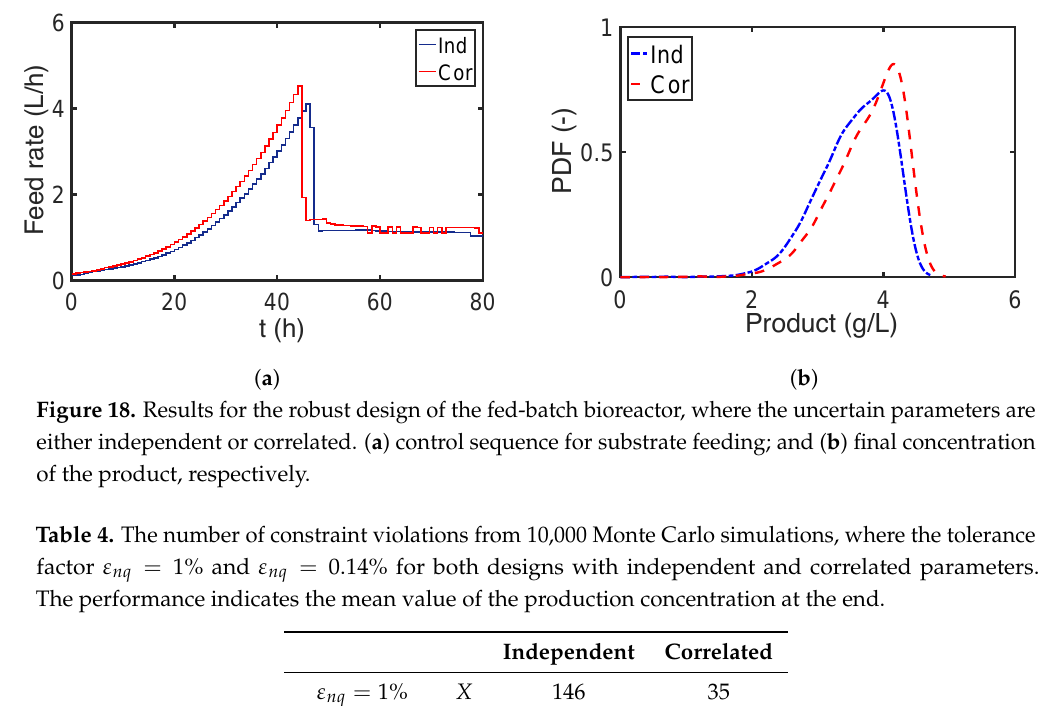
Figure 17. Evolution of the mean and 99% confidence interval (CI) of the ( a ) biomass and ( b ) substrate concentrations for the robust design of the fed-batch bioreactor, where the uncertain parameters are correlated. The feeding profile from the robust design with correlated uncertain parameters is applied.